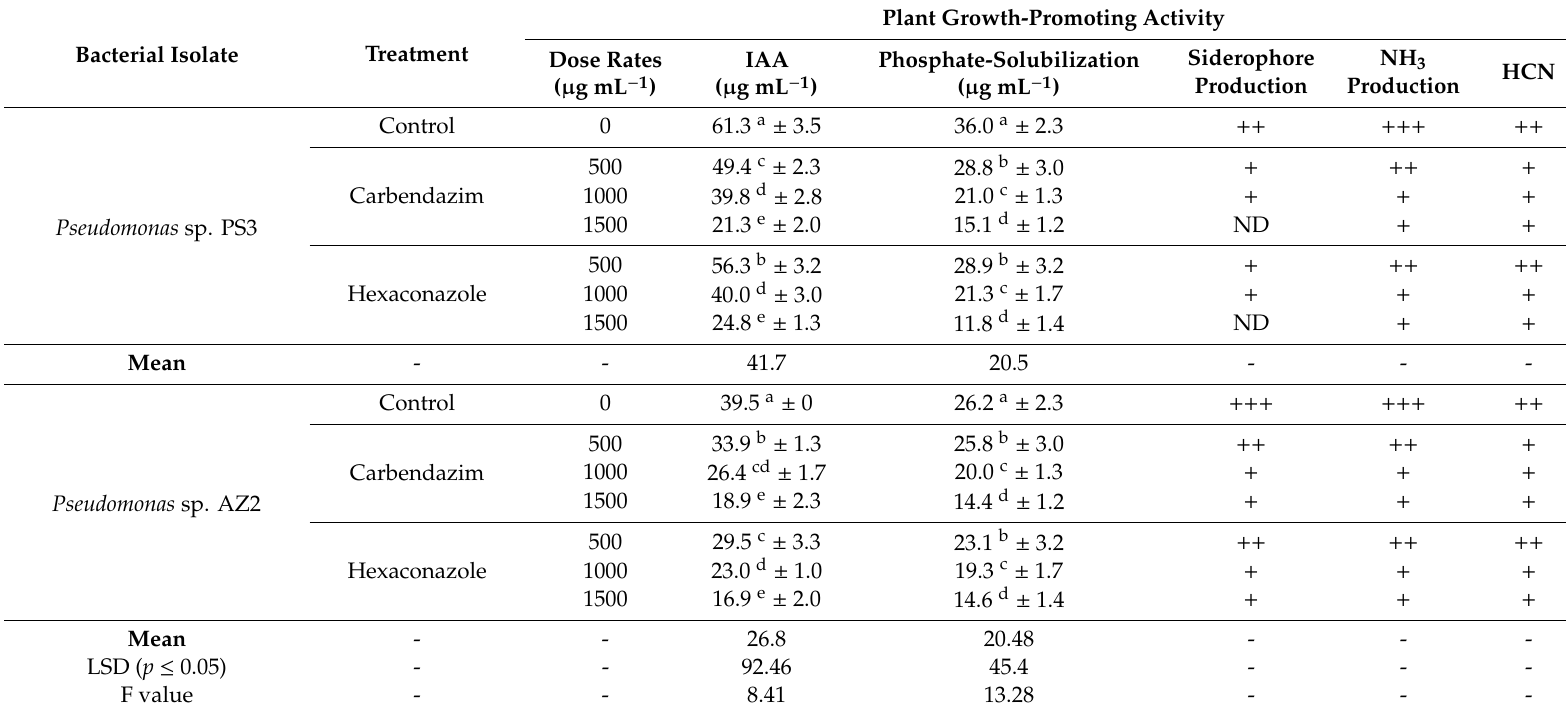
Table 2. Plant growth-promoting activities of bacterial isolates under